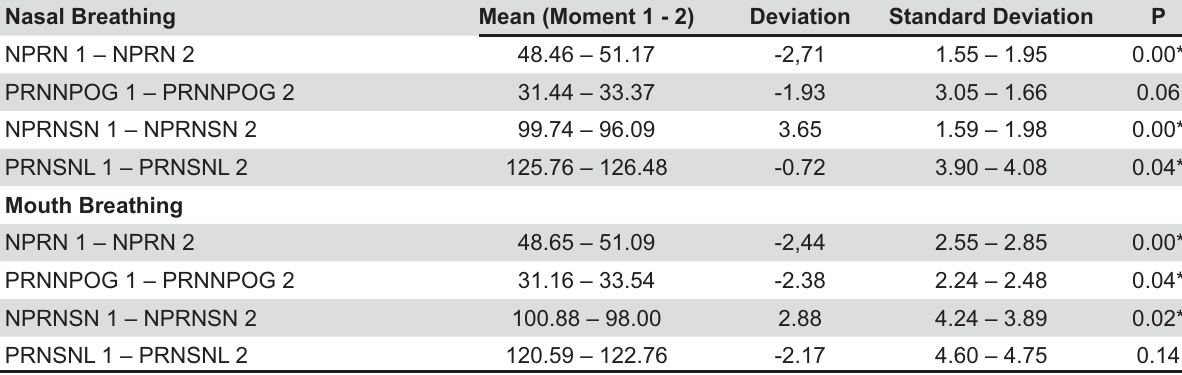
Table 5- Comparison between nose measurement in nasal and mouth breathing according to the moments